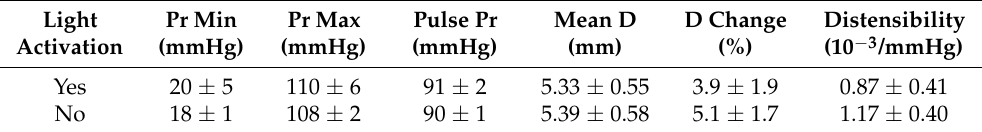
Table 1. Human Vein Bench Top Biomechanics Test Conditions and Results.